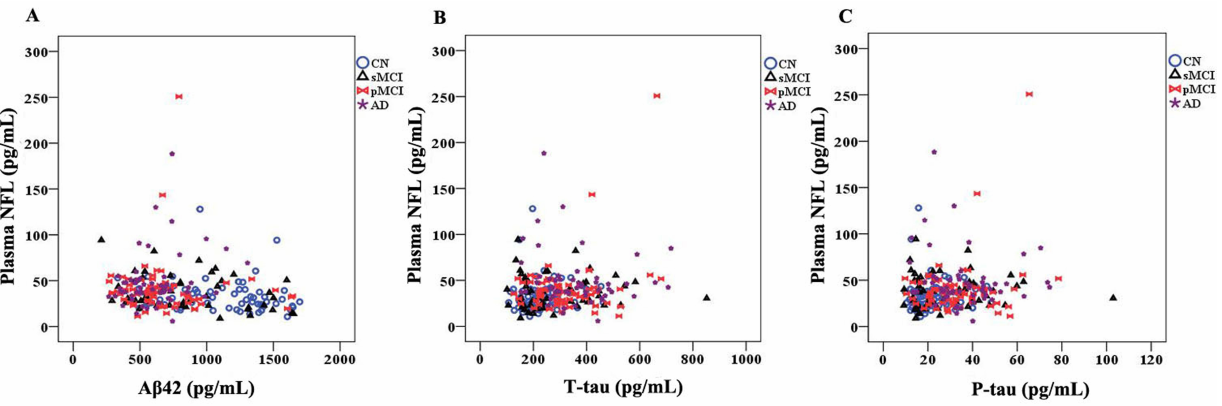
Fig.3. PlasmaNFLinrelationtootherbiomarkers. There are relationships between plasma NFL and A β 42 (A) and tau biomarkers (B and C) in different